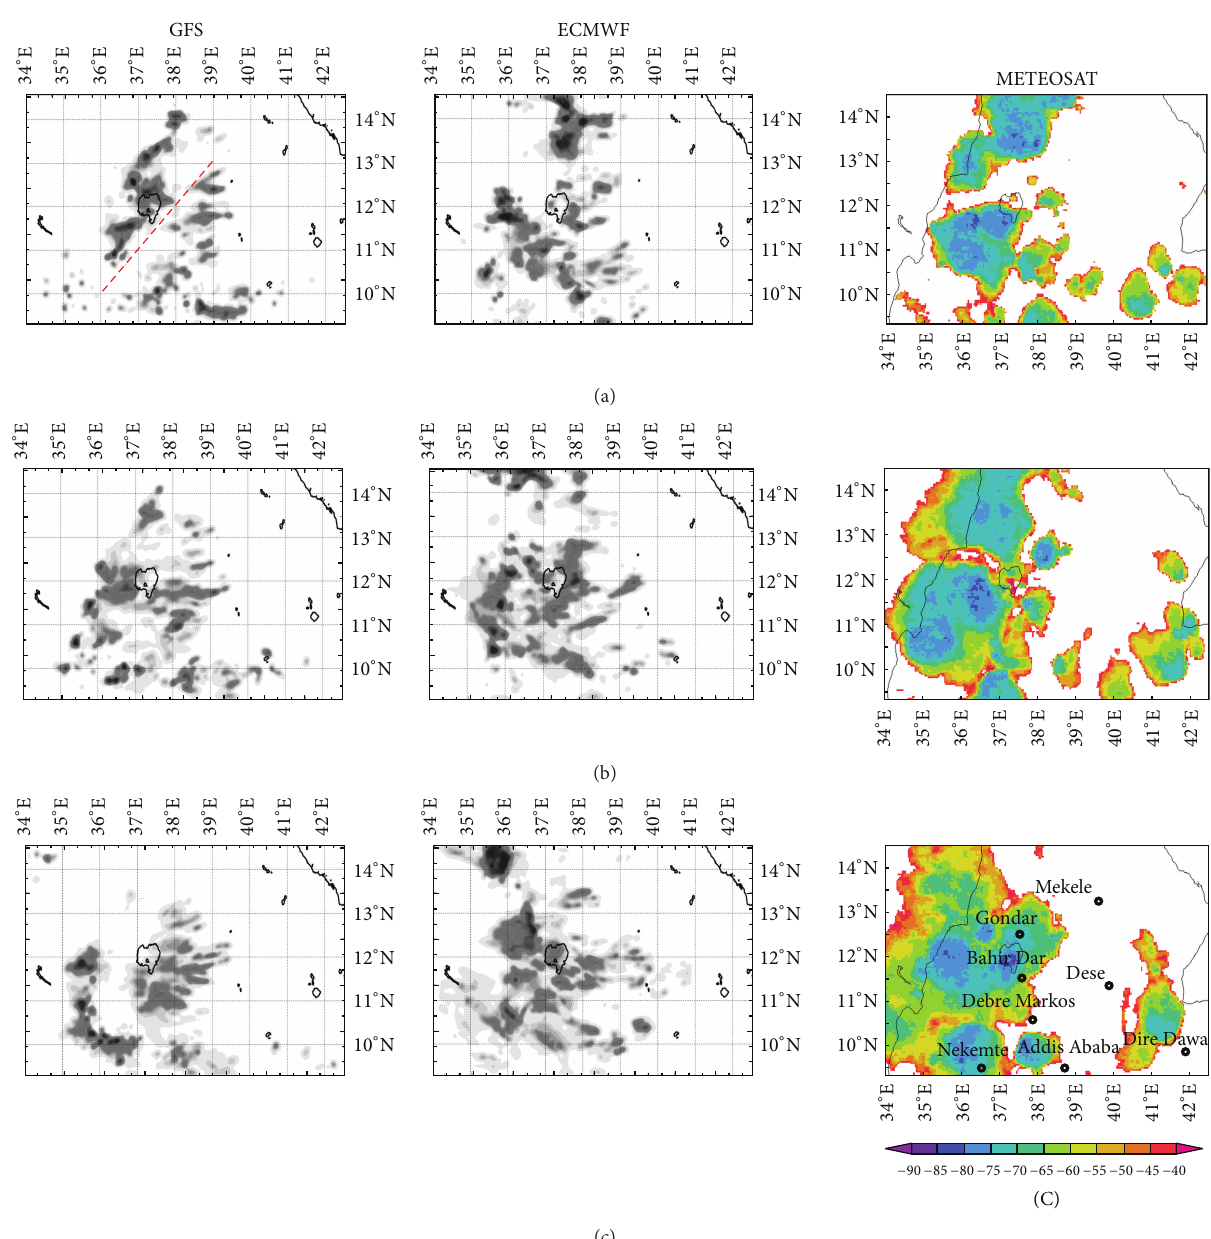
Figure 9: WRF simulated rainfall on 29 July for (a) 18:00, (b) 20:00, and (c) 22:00 LST, with max shading = 75 mm/day. GFS initialization (left), ECMWF (middle), and comparison with Meteosat IR images (right). Red dashed line in (a, left) is Figure 8 section.